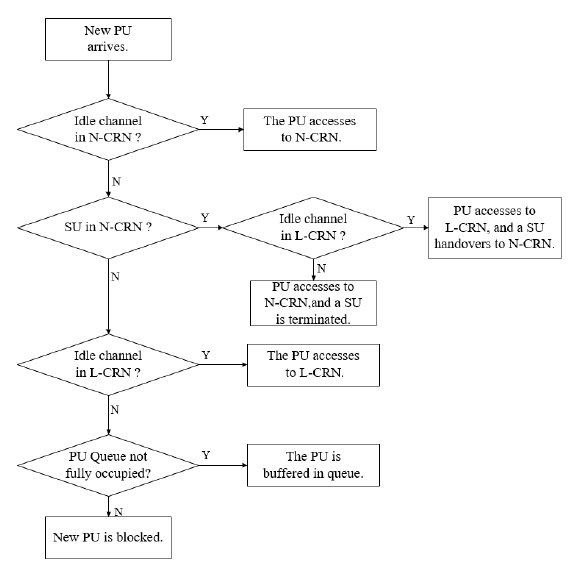
Figure 3. The procedure when a new primary user (PU) arrives.